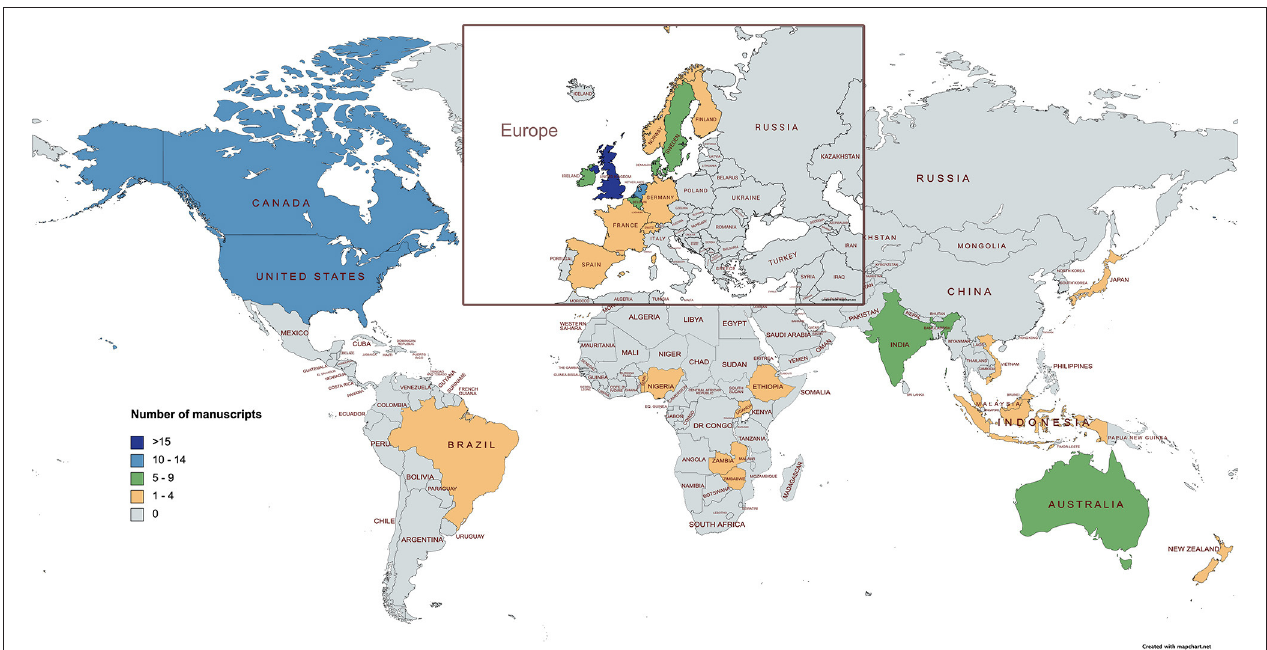
FIGURE 3 | Worldwide distribution of manuscripts on farmers’ behavior concerning cattle disease prevention and control.